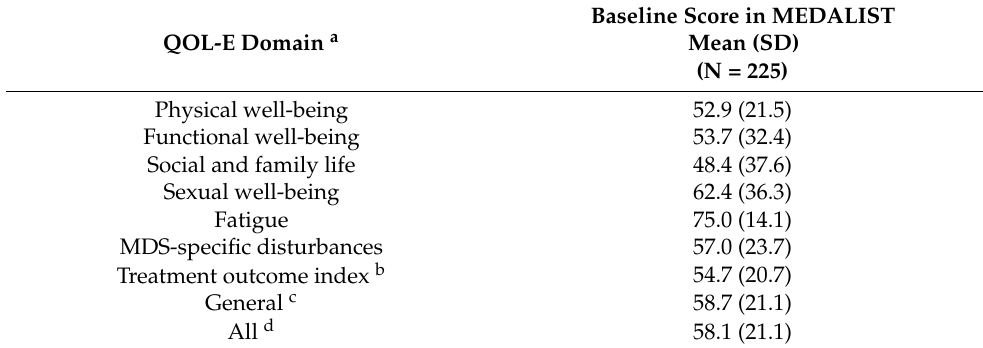
Table 4. Baseline QOL-E scores.